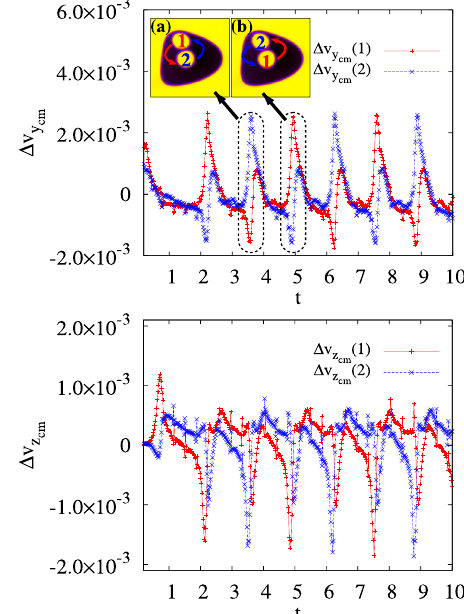
Fig. 6 Speed of the cores. Time evolution of the y and z components of the velocity of center of mass of the two cores computed with respect to that of the external droplet. The inset highlights the position of the inner drops at the points of inversion of motion. Red and blue arrows indicate their direction of motion. Snaphots are taken at t = 3.6 × 10 5 ( a ) and t = 4.94 × 10 5 ( b ) (core 1) approaches the one at its front (core 2), since it moves slightly faster due to the larger fl ow fi eld in the middle line of the emulsion (see Fig. 4, and position and speed of their center of mass for t < 10 5 in Figs. 5 and 6). This results in a dynamic chain- like aggregate of droplets, moving together towards the leading edge of the external interface. Note that droplet merging is inhibited, since the repulsion among cores (mimicking the effect of a surfactant) is included (see section “ Methods ” ). the fl ow fi eld, an effect due to the non-trivial coupling between